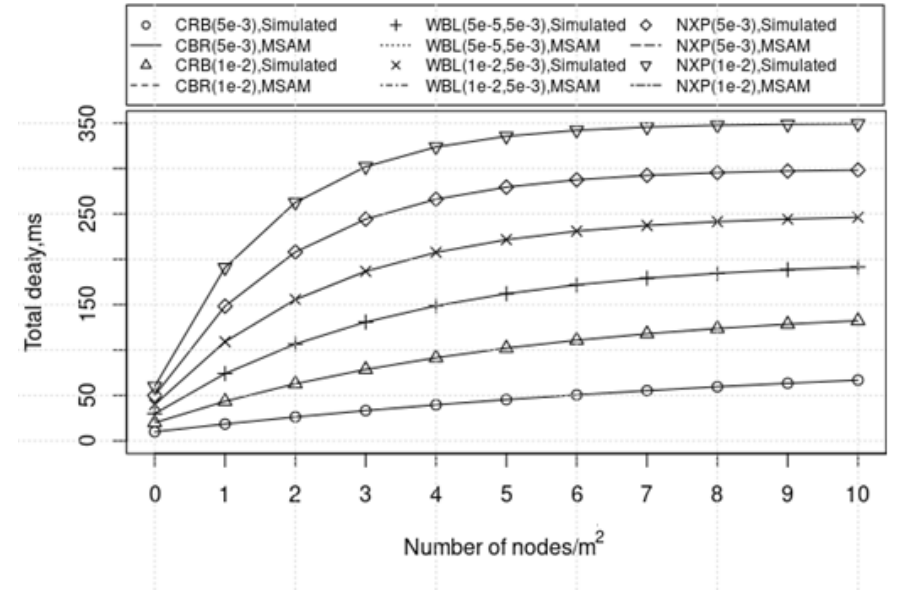
Figure 9. Total delay vs. network density.